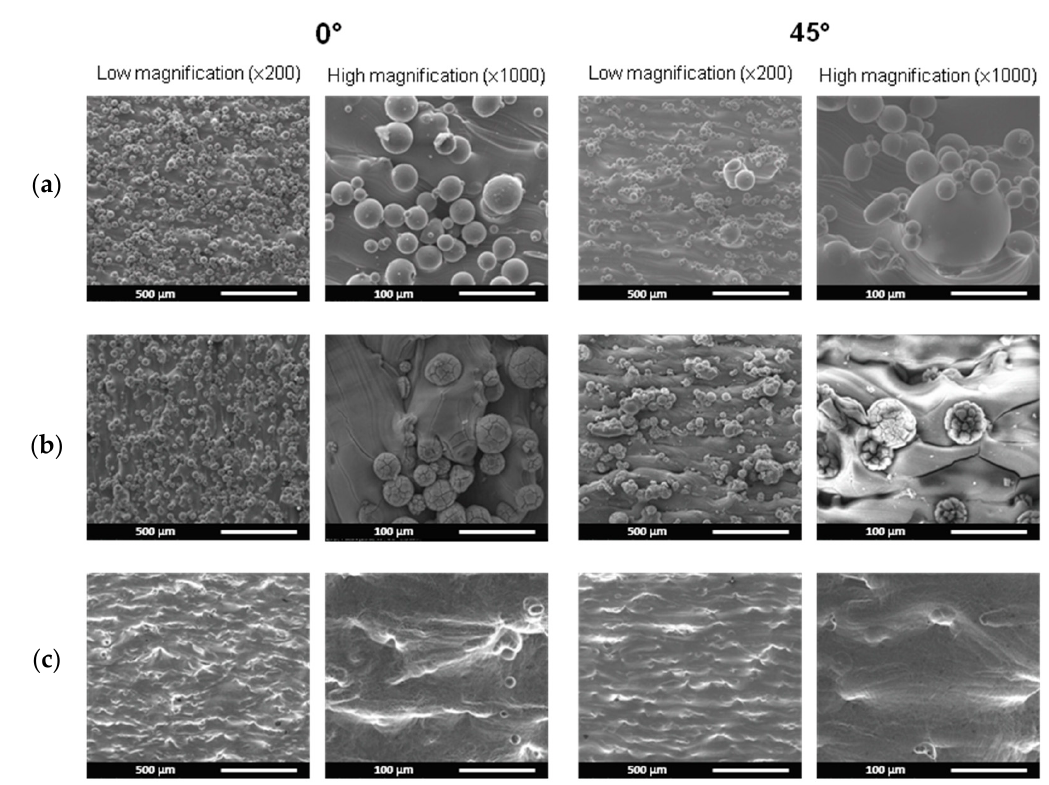
Figure 1. Micrographs illustrating the surface topography of the Ti6Al4V samples manufactured by SLM at 0° and 45°: as-built ( a ), with post-processing treatments anodization ( b ) and etching ( c ).